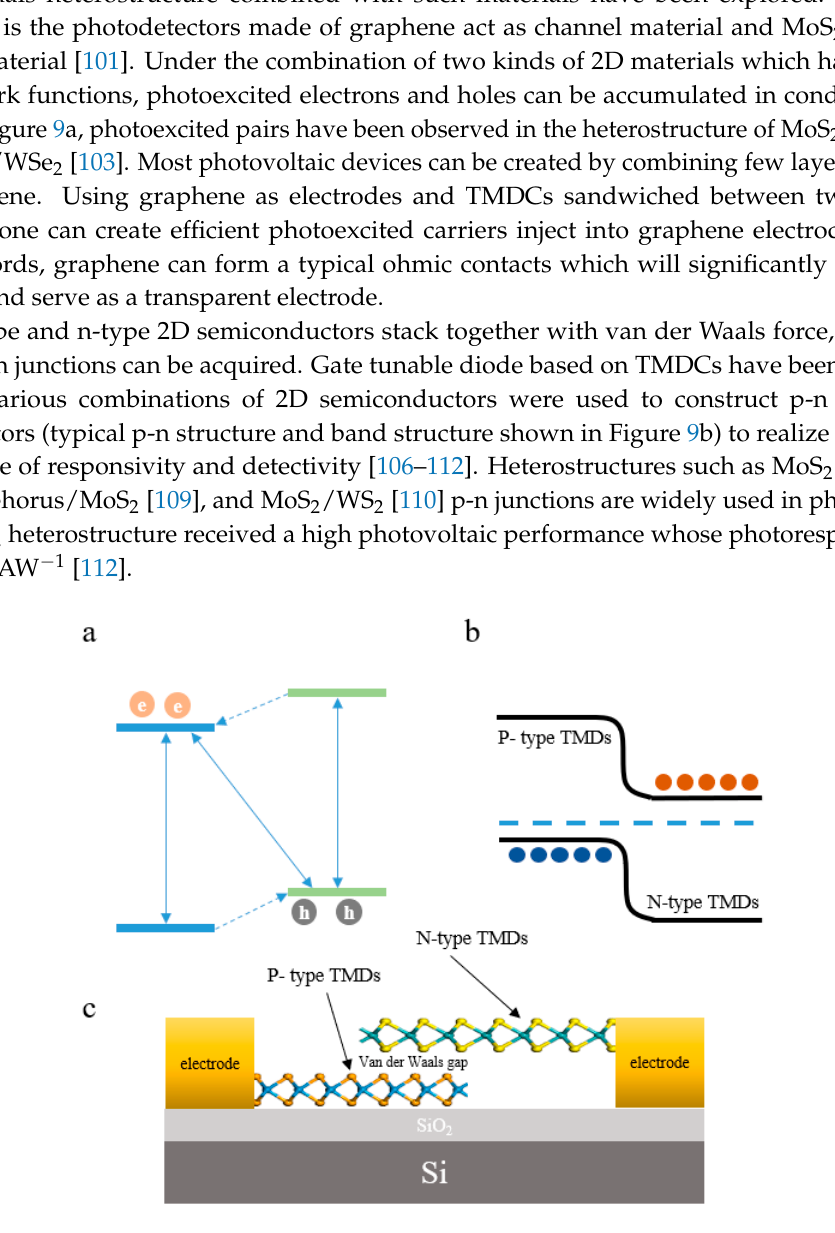
Figure 9. Photodetector and diodes schematic diagram: ( a ) photoexcited pairs generate in MoS 2 /WSe 2 heterostructure; ( b ) band structure of n-MoS 2 and p-WSe 2 p-n junction; and ( c ) schematic illustration of vertical stack p-n diode based on two-dimensional TMDs.